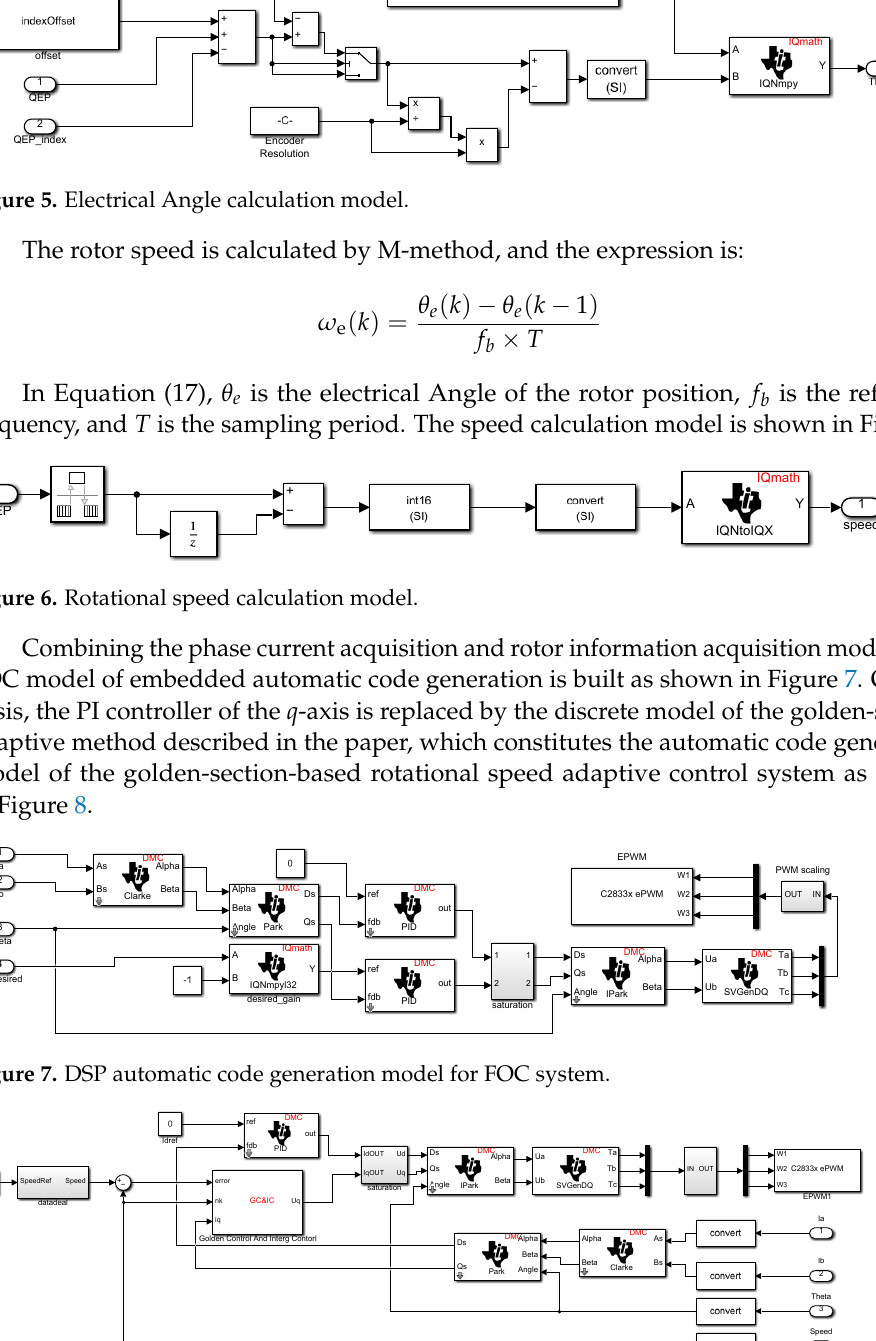
Figure 8. Golden-section speed adaptive code generation model. 5. Simulation and Experimental Research The control chip used in this paper is TMS320F28335, with a floating point processing unit, and the motor is a surface mount low-voltage permanent magnet synchronous mo- tor, whose specific parameters are shown in Table 1. The actual hardware of the overall system is shown in Figure 9. the speed sensor is an incremental photoelectric encoder, its model is H40-6-0500VL, 500 pulses per circle, and maximum support speed is 8000 rpm. This platform is used as the verification system to verify the PMSM’s linear golden-section rotational speed adaptive control system.